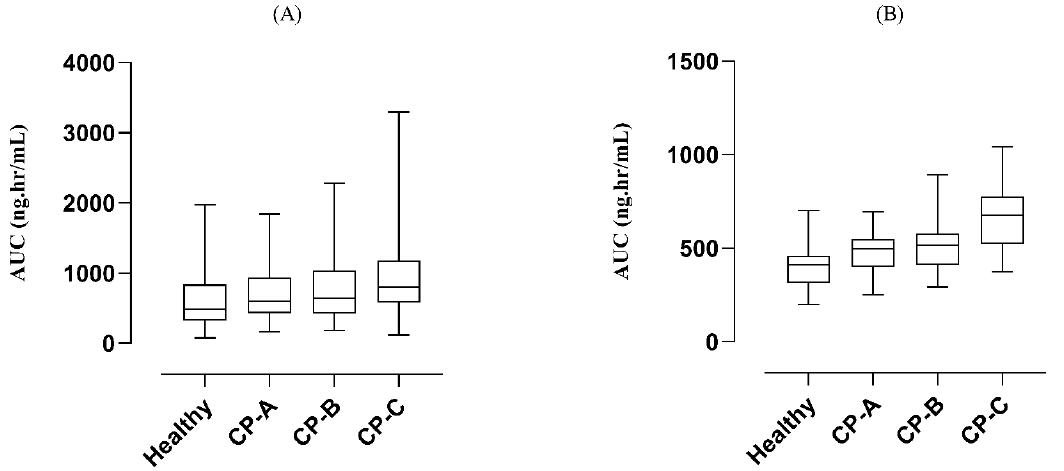
Figure 5. Box-whisker plots after ( A ) oral (200 mg) and ( B ) IV (0.5 mg/kg) dose of labetalol in healthy, CP-A, CP-B, and CP-C populations to compare AUC.